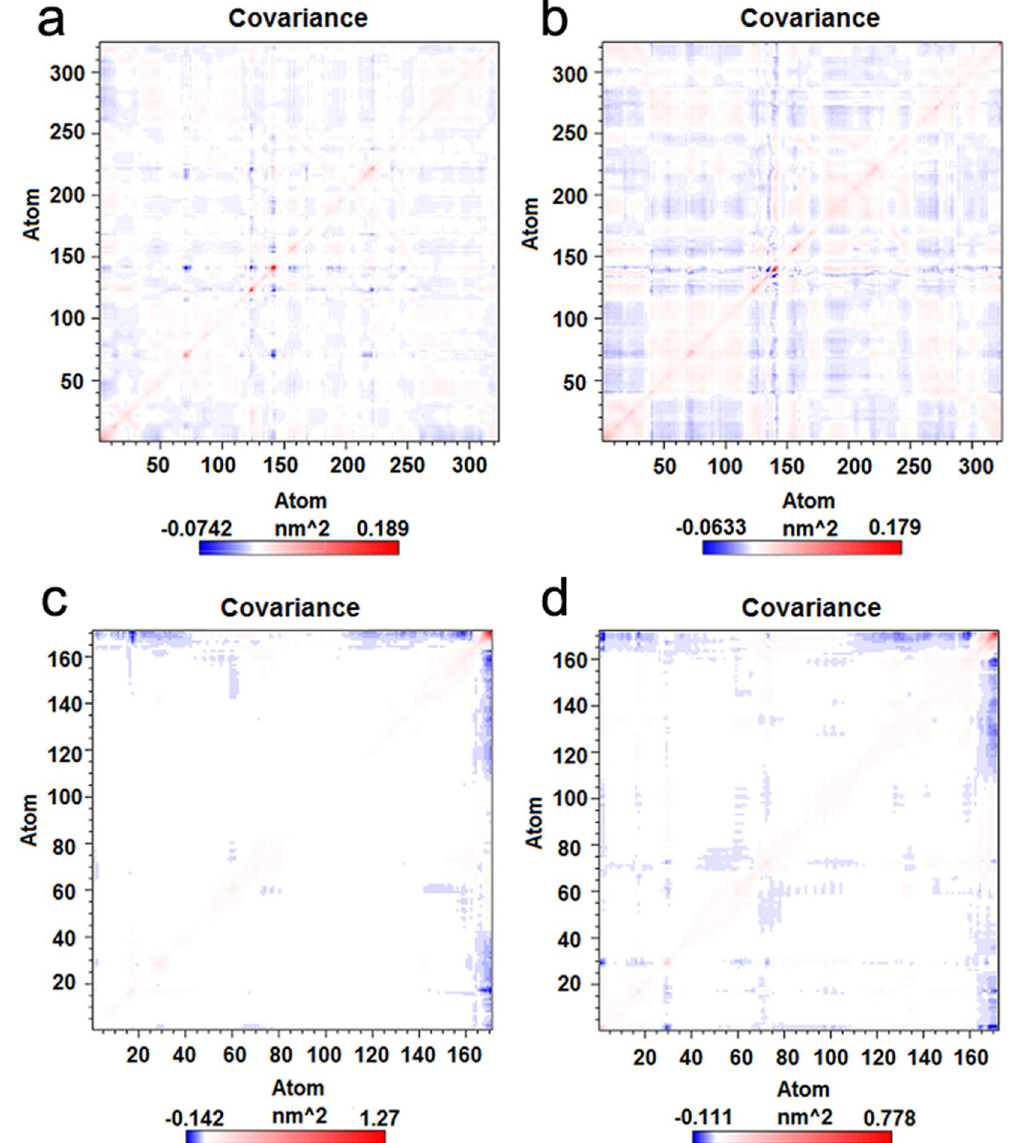
Figure 2. Cross-correlation matrix of the fluctuations of each of the x, y, and z coordinates of the C α atoms of HA from their average during molecular dynamics simulations. ( a ) C α atoms from HA1 of HA Washington . ( b ) C α atoms from HA1 of HA Florida . ( c ) C α atoms from HA2 of HA Washington . ( d ) C α atoms from HA2 of HA Florida